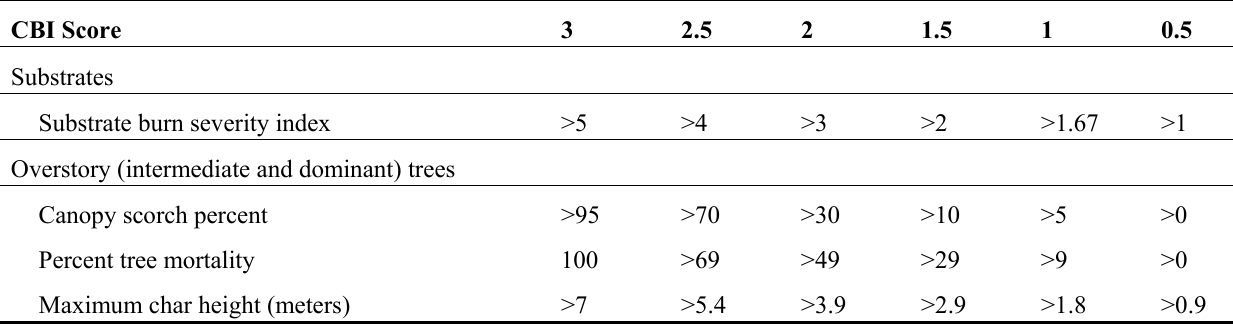
Table 4. Factors used to convert forest plot measurement to CBI scores.